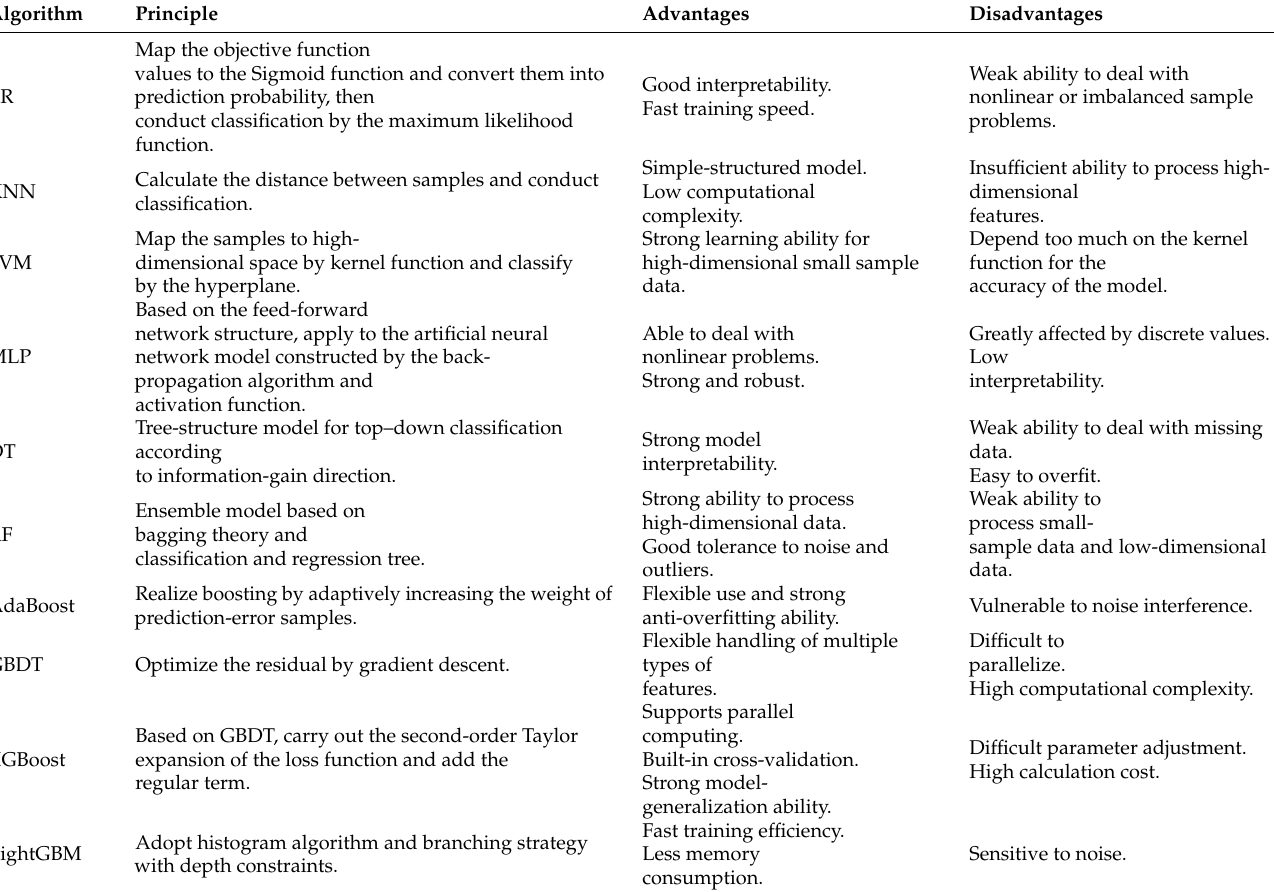
Table 1. Analysis of the classification